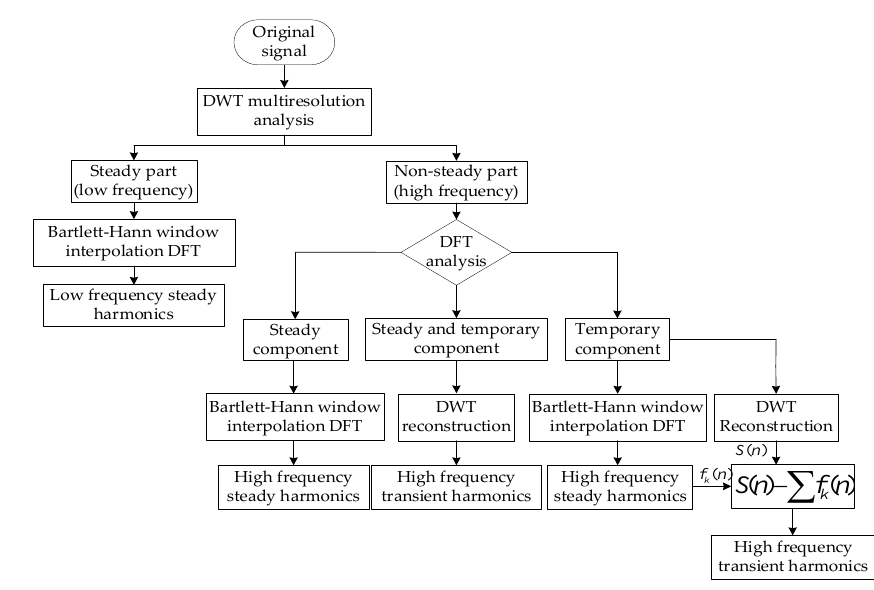
Figure 3. Harmonic detection improvement method flowchart.